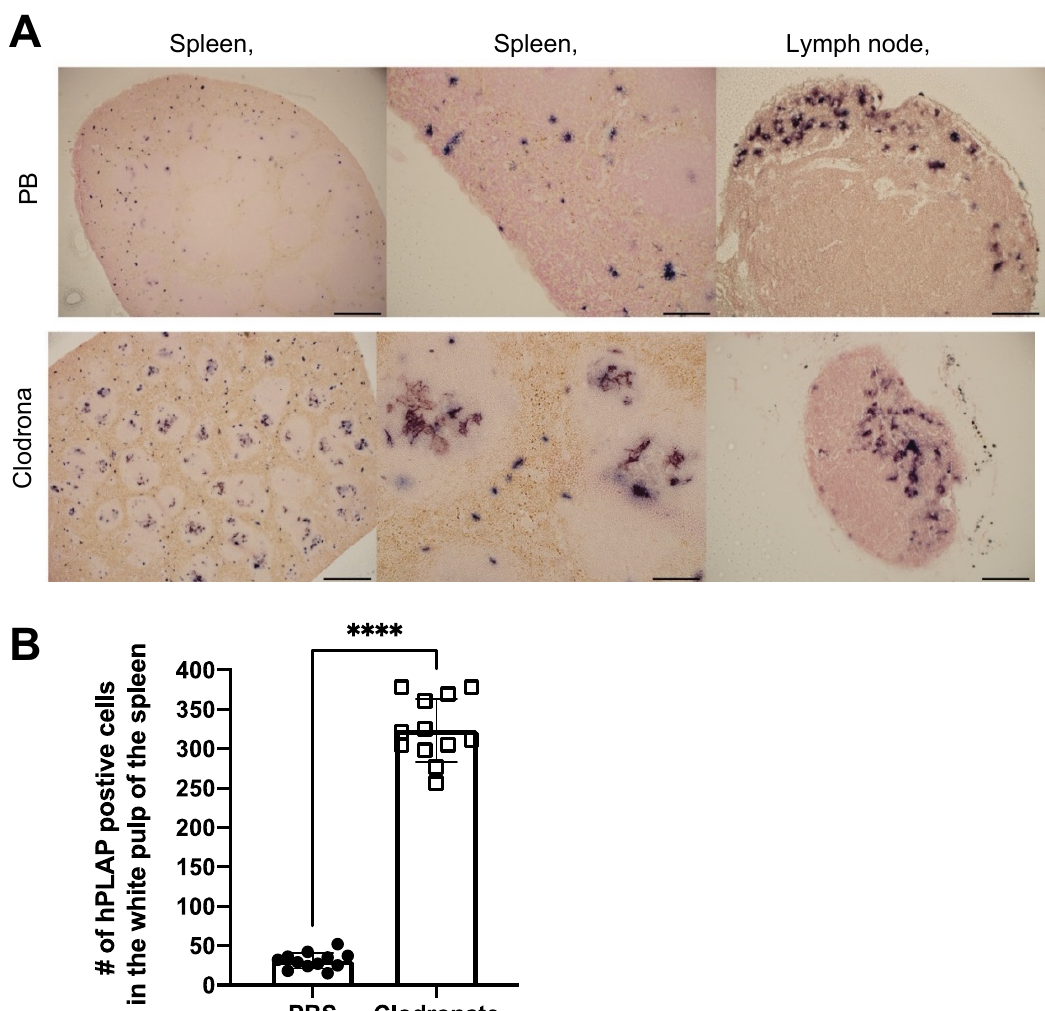
Figure 5. Histochemical staining of sections from spleen and lymph node in clodronate-treated and control mice. ( A ) Representative tissue sections of spleen and lymph node from clodronate-treated mice and control mice. Both groups were administered 1 × 10 11 vg of AAV vector expressing human placental alkaline phosphatase (hPLAP) via tail vein injection and euthanized 28 days later. Tissues were formalin fixed, paraffin embedded, and stained for hPLAP expression. Administration of clodronate appeared to allow improved AAV transduction of white pulp relative to control mice. hPLAP staining in the center of the white pulp could be observed for clodronate-treated mice, whereas with control mice, no such staining could be observed. The presence of marginal zone macrophages likely prevented efficient transduction of white pulp in control mice. Within the lymph node, staining seemed to be restricted to the periphery of the lymph node for control mice, whereas in clodronate-treated mice, staining could be observed in the center. ( B ) Quantification of hPLAP positive foci in the white pulp of spleens from clodronate-treated and control mice. Foci of hPLAP stained cells in the white pulp of the spleen from three tissue sections (4×) per mouse per group were counted. 4× scale bar = 200 μ M, 10× scale bar = 100 μ M, 20× scale bar = 50 μ M. Data were analyzed using an unpaired t -test, **** = p <0.0001.